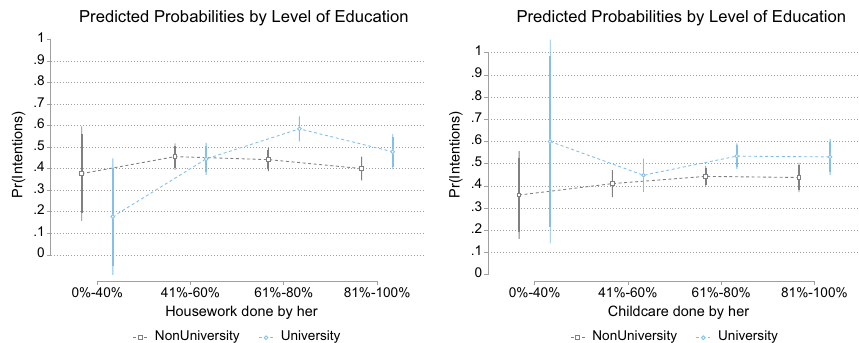
Fig. 5 Predicted probabilities of one-child mothers’ fertility intentions. Interaction between housework/ childcare distribution and mothers’ educational attainment. Error bars at 90% (thin) and 95% (thick). Models control for housework/childcare duties done by other individuals, woman’s age, child’s age, migrant background, women’s attachment to the labour force, men’s labour force status, differences in partners’ educational attainment, partner’s children and women’s partnership